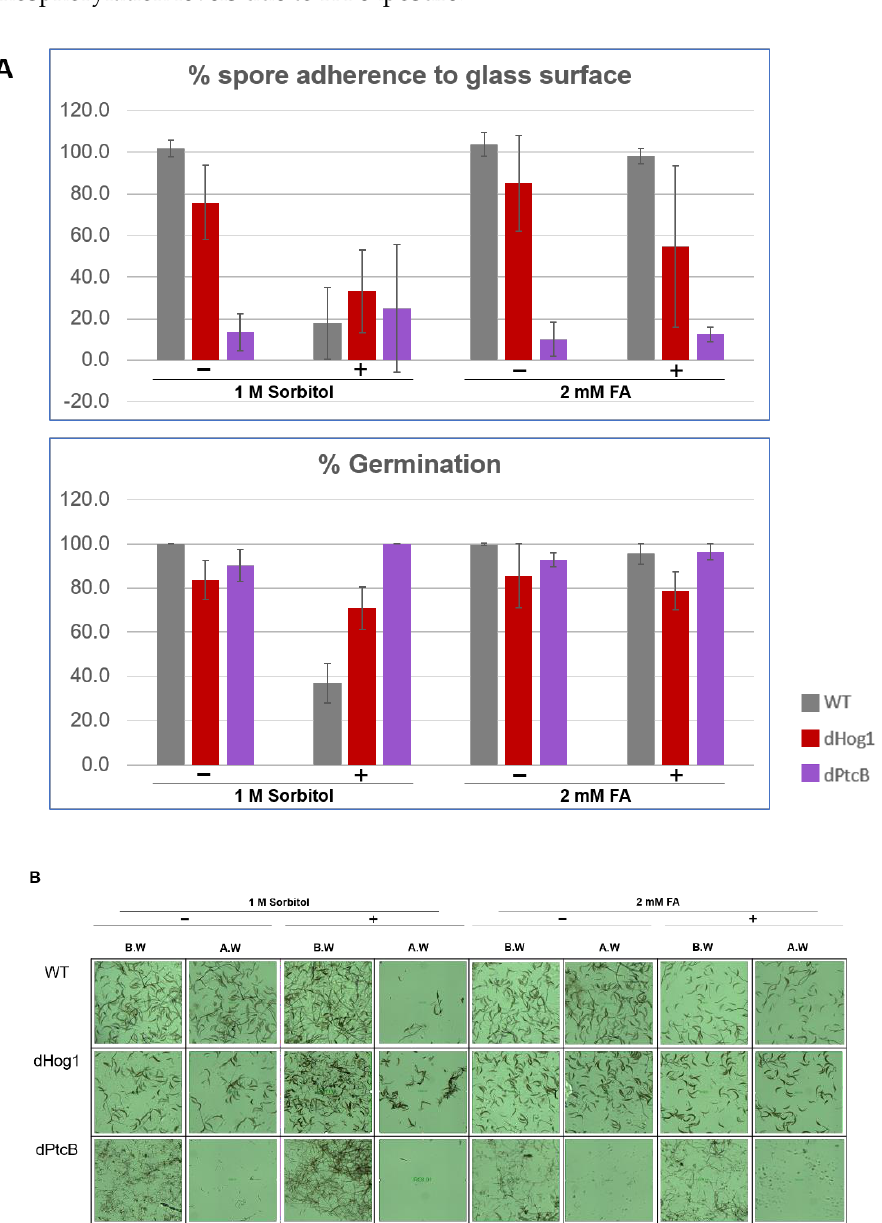
Figure 8. Spore attachment and germination of strains on stress-inducing growth media. ( A ) The percentage of the spore attachment and germination. C. heterostrophus C4 WT strain and mutants were grown in CM agar plates with or without sorbitol ( − or + 1 M sorbitol), or CM with 0.15% v/v DMSO with or without FA ( − or + 2 mM FA), for 14 d (8 h/16 h dark/light cycles). Spore suspensions were collected from each, and were incubated on a cover slip in a humid chamber for 1.5 h (see Methods). The pictures were taken using a Leica DMI8 inverted microscope. Each droplet was washed twice with 50 µL DDW and documented again. The image processing was performed using the LASX program. Standard deviation bars were added. ( B ) Representative pictures corresponding to the treatments in panel A.